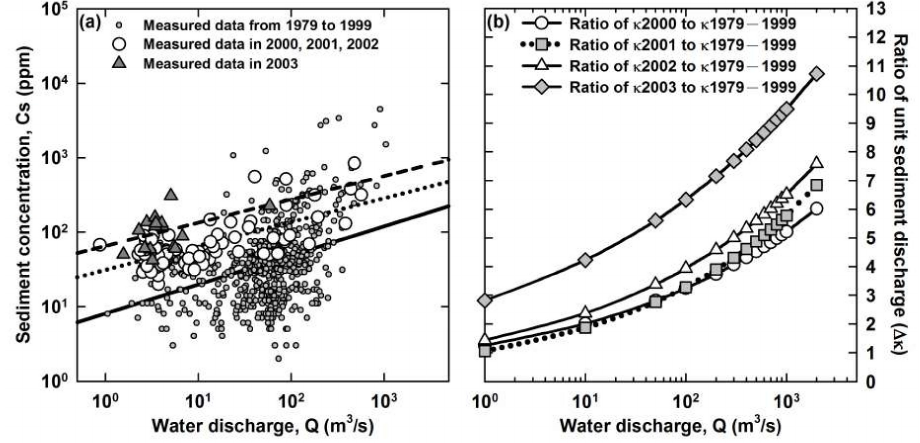
Figure 3. ( a ) The Cs–Q relationships before and after the 1999 Chi-Chi earthquake in the Tachia River. ( b ) The ratios of unit sediment concentrations after and before the 1999 Chi-Chi earthquake in the Tachia River.